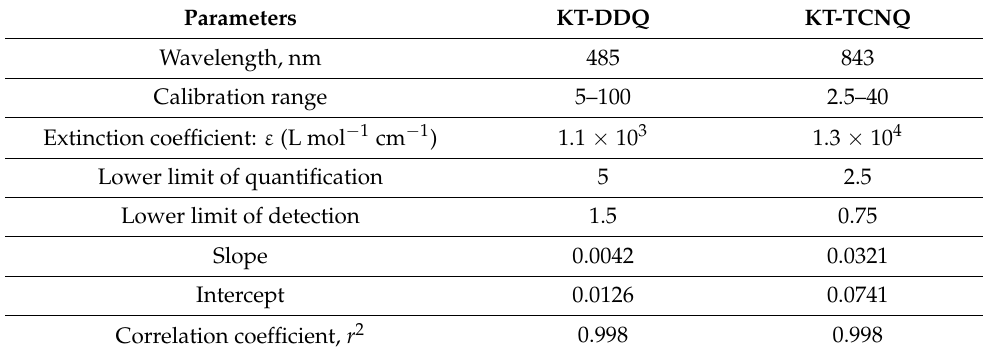
Table 3. Spectrophotometric characterization parameters for the KT-DDQ and KT-TCNQ complexes.